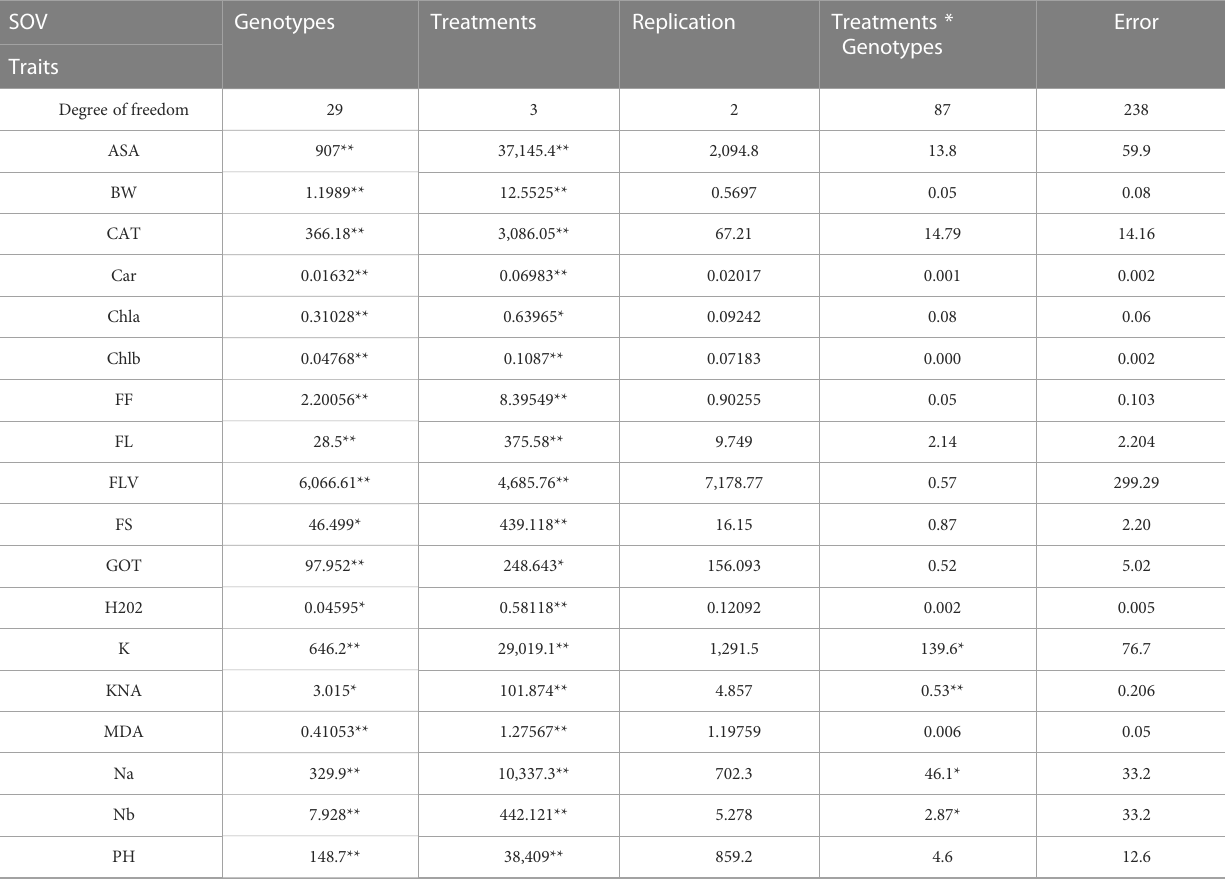
TABLE 1 First year mean square values for various agro-physiological, biochemical, and fi ber quality traits of 30 cotton genotypes under four treatments.